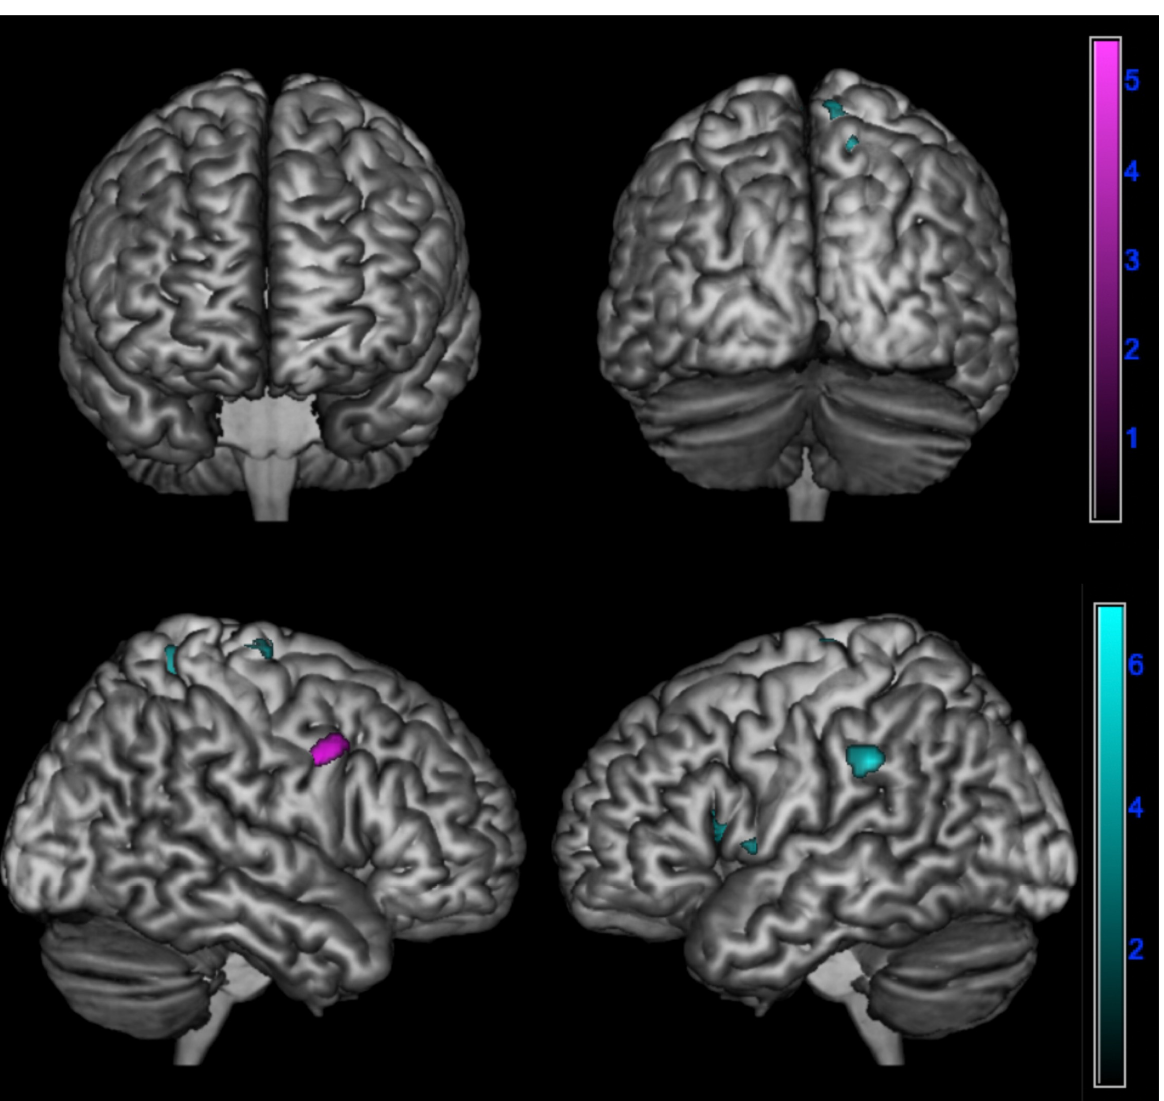
Figure 4. Positive correlation between changes in emotional contagion over time assessed by ∆ PD (PD-T0 - PD-T1) and brain metabolism in logopenic primary progressive aphasia and amnesic Alzheimer’s disease patients at 18F-FDG-PET SPM analysis. Significant clusters projected on the standardized Montreal Neurological Institute (MNI) magnetic resonance imaging (MRI) render surface. Color grading: cyan, lv-PPA; violet, amnesic AD.